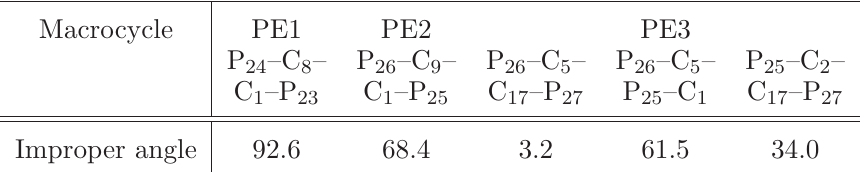
Table 4 Improper angles between phosphinine units in phosphinine-ether macrocycles obtained from PM3 calculation (deg) [41].